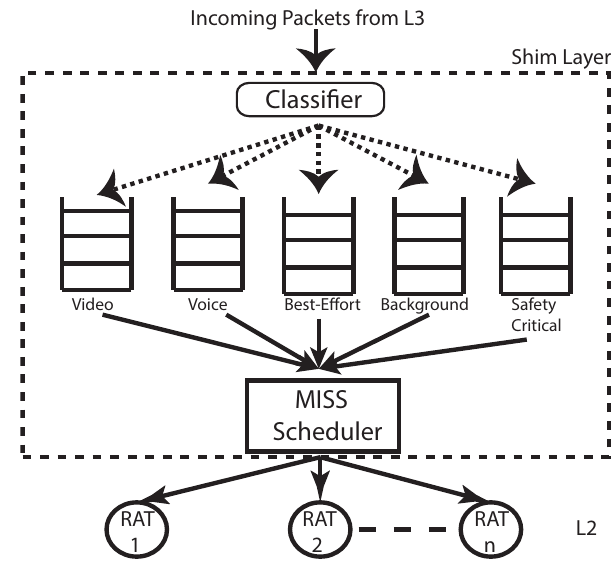
Figure 2. Detailed consistency of shim